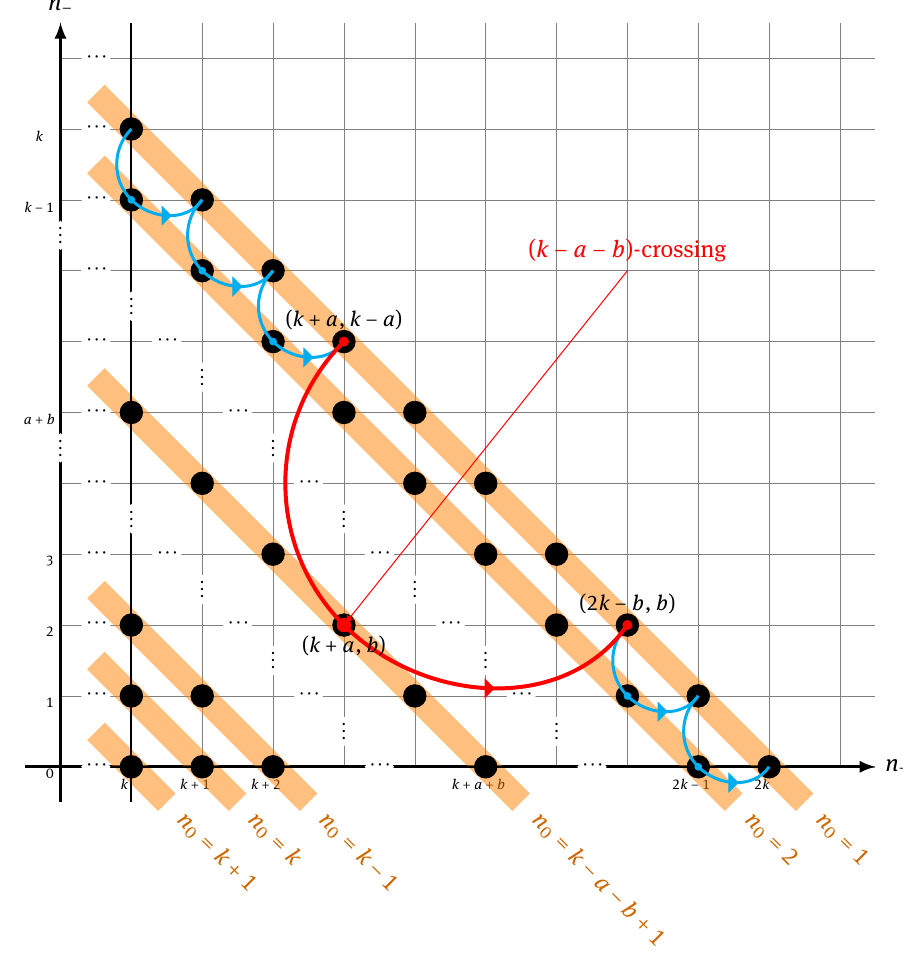
Figure 6: The lattice of pairs ( n + , n − ) of Laplacian inertias of G · G · ··· · G where G = K 3 with two negative edges and a positive edge, and G is repeated k